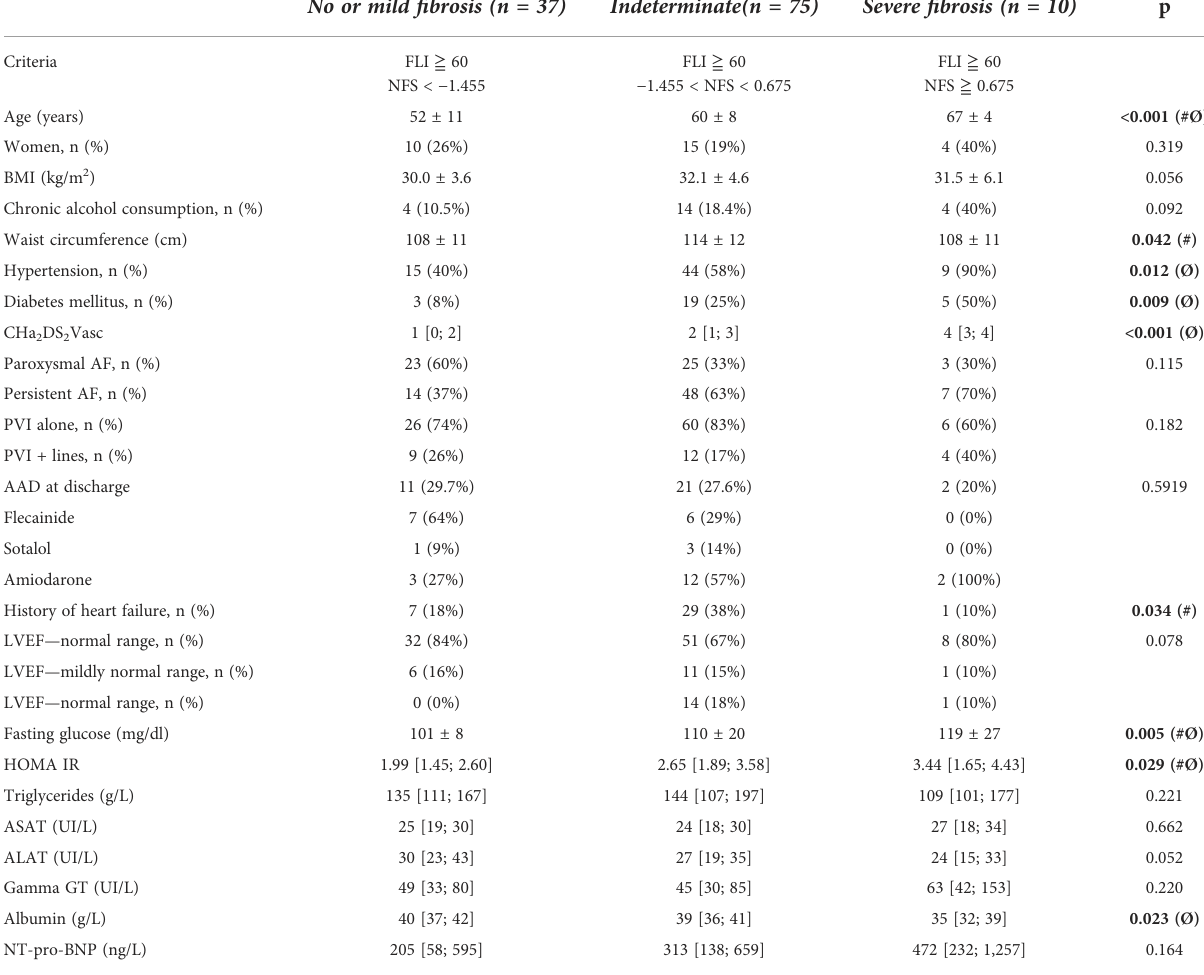
TABLE 2 Baseline characteristics of adults with MAFLD diagnosis classi fi ed according to liver fi brosis risk using the NAFLD Fibrosis Score